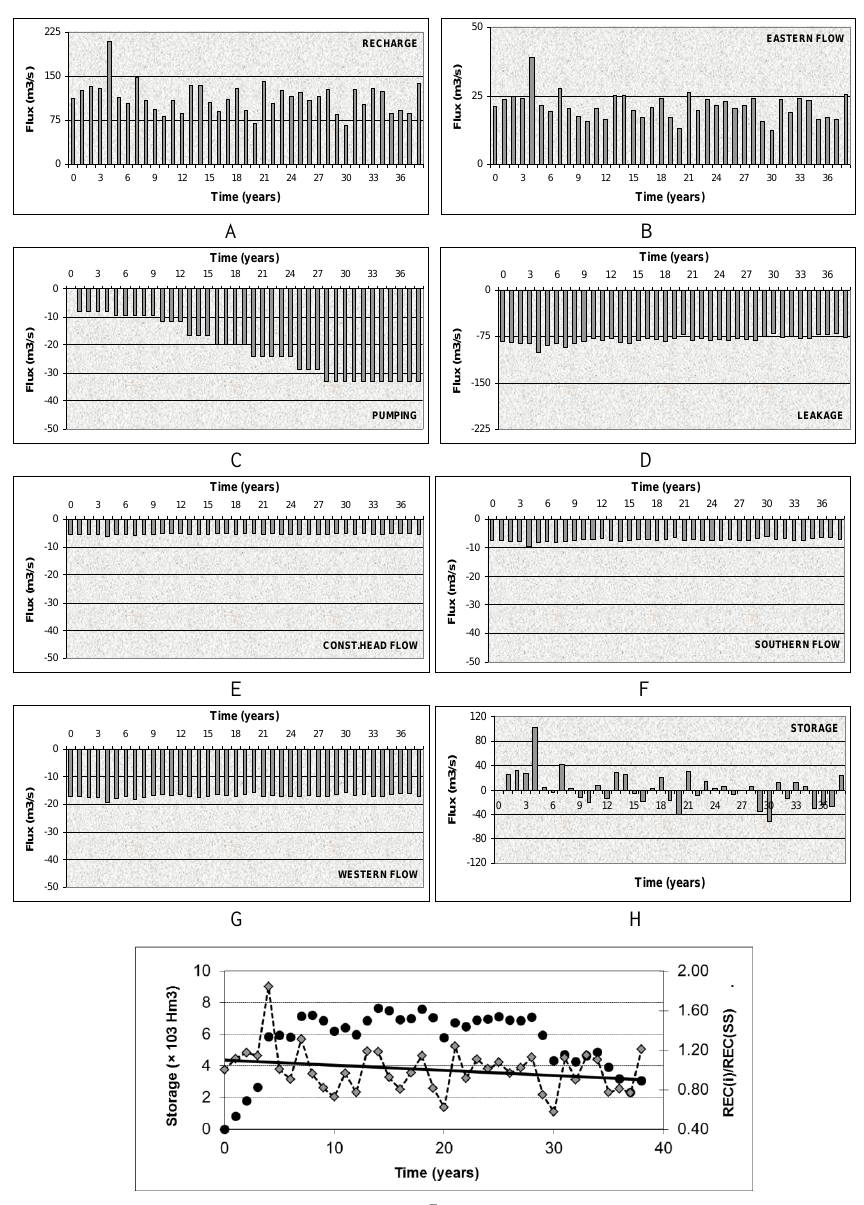
Fig. 9. Model water budget components for zonation Z5. Flow rates are expressed in m 3 s − 1 , volumes are expressed in Hm 3 . Negative flows represent water out of the aquifer, positive flows represent water into the aquifer. (A) , (B) , (C) , (D) , (E) , (F) , (G) and (H) : annual water budget terms; (I) : cumulative storage (black circles), relative recharge (gray